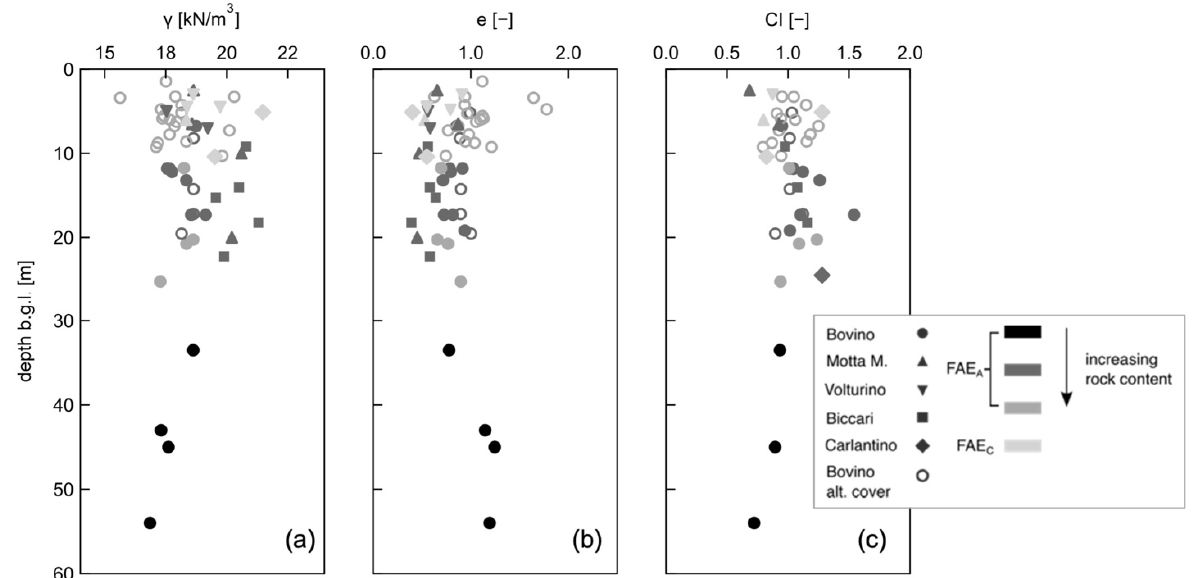
Figure 16. Physical and state properties of Faeto Flysch: total unit weight ( a ); void ratio ( b ), consistency index ( c ).